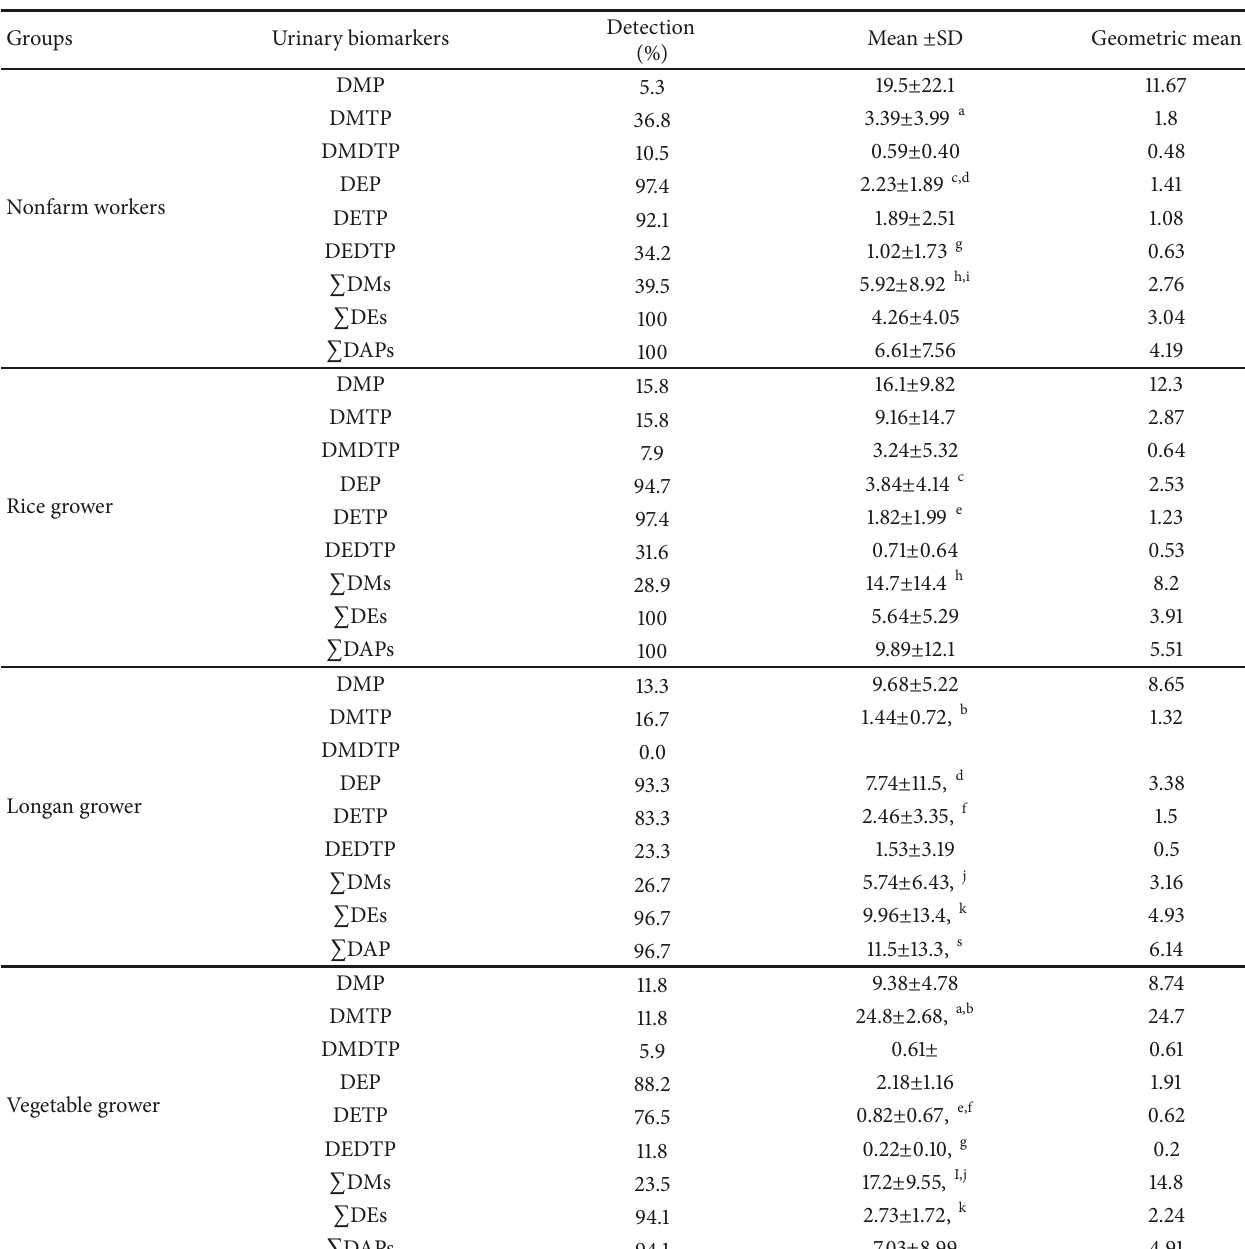
Table 4: Presence of urinary biomarkers of organophosphate pesticides exposure, by study group.